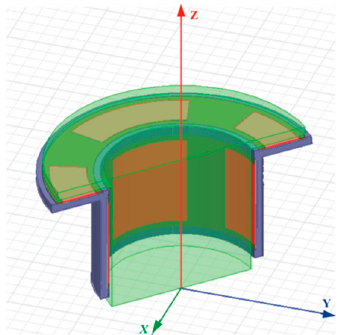
Figure 9. Simulation model of T-type CS.